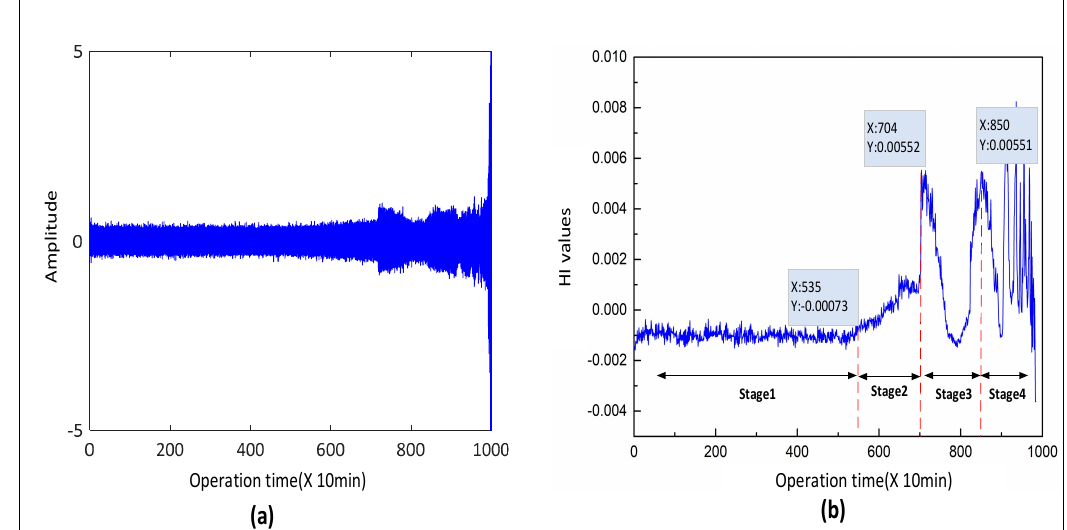
Figure 5. ( a ) Time-domain waveform of bearing, ( b ) health stage division of bearing.